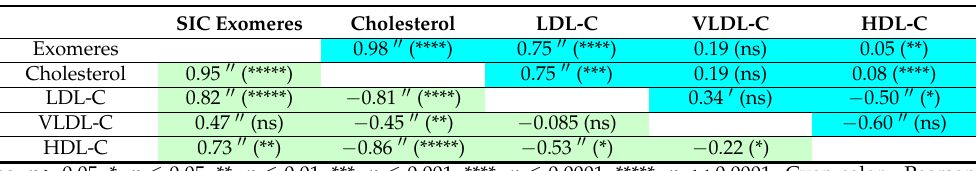
Table 2. Pearson correlation and partial correlation coefficients of lipid profile parameters and SIC exomeres group “Before therapy”.